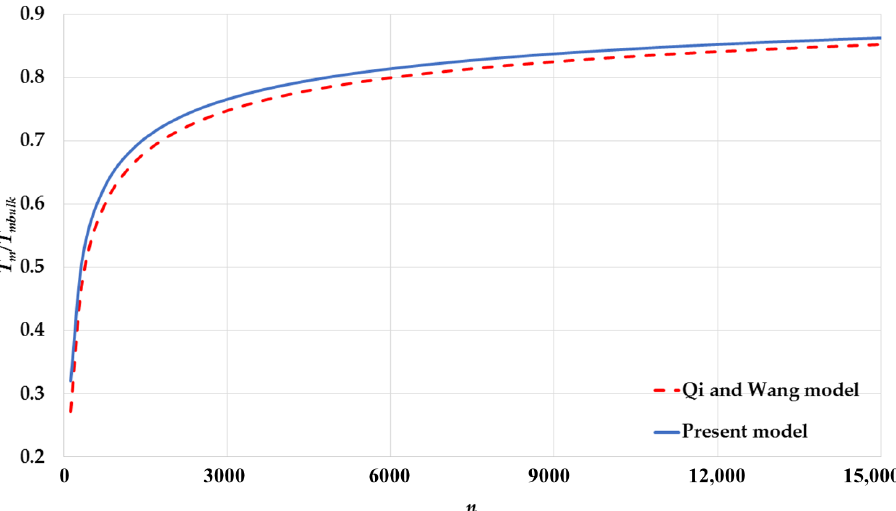
Figure 5. The variation of ratio T m / T mbulk as function of number of atoms n of spherical nanoparticles in an SC structure using the present model and compared to Qi and Wang model [24].